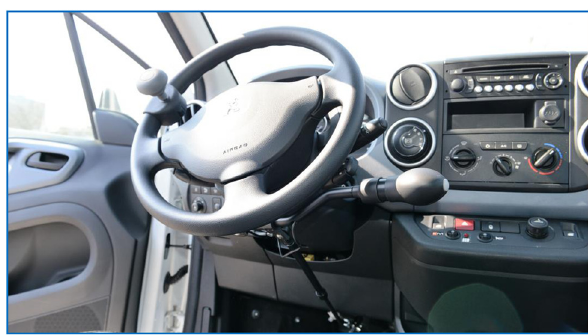
Figure 2: Gas/brake device, horizontally installed under the steering wheel.